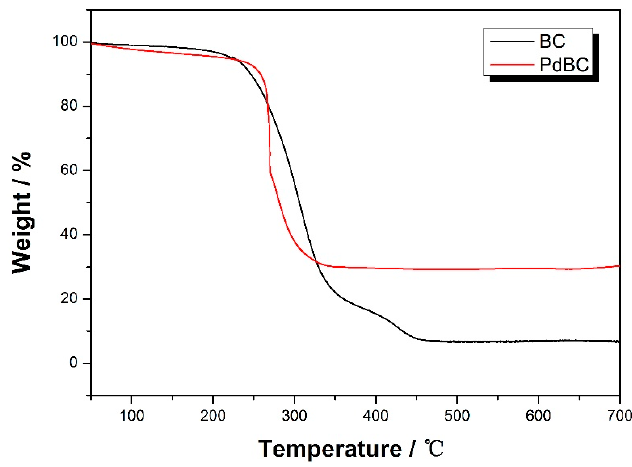
Figure 4. Thermogravimetric analysis (TGA) curve of BC nanofibers and PdBC nanofibers.